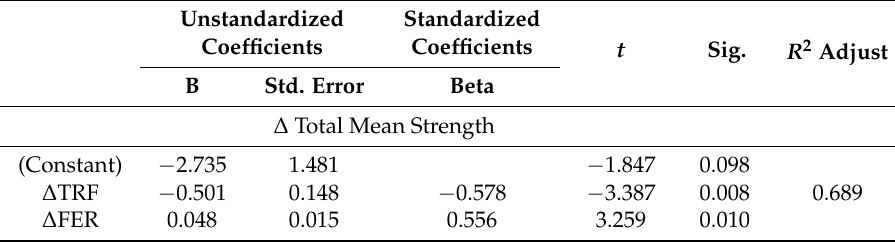
Table 2. Regression multivariate analysis with strength tests as the dependent variable.